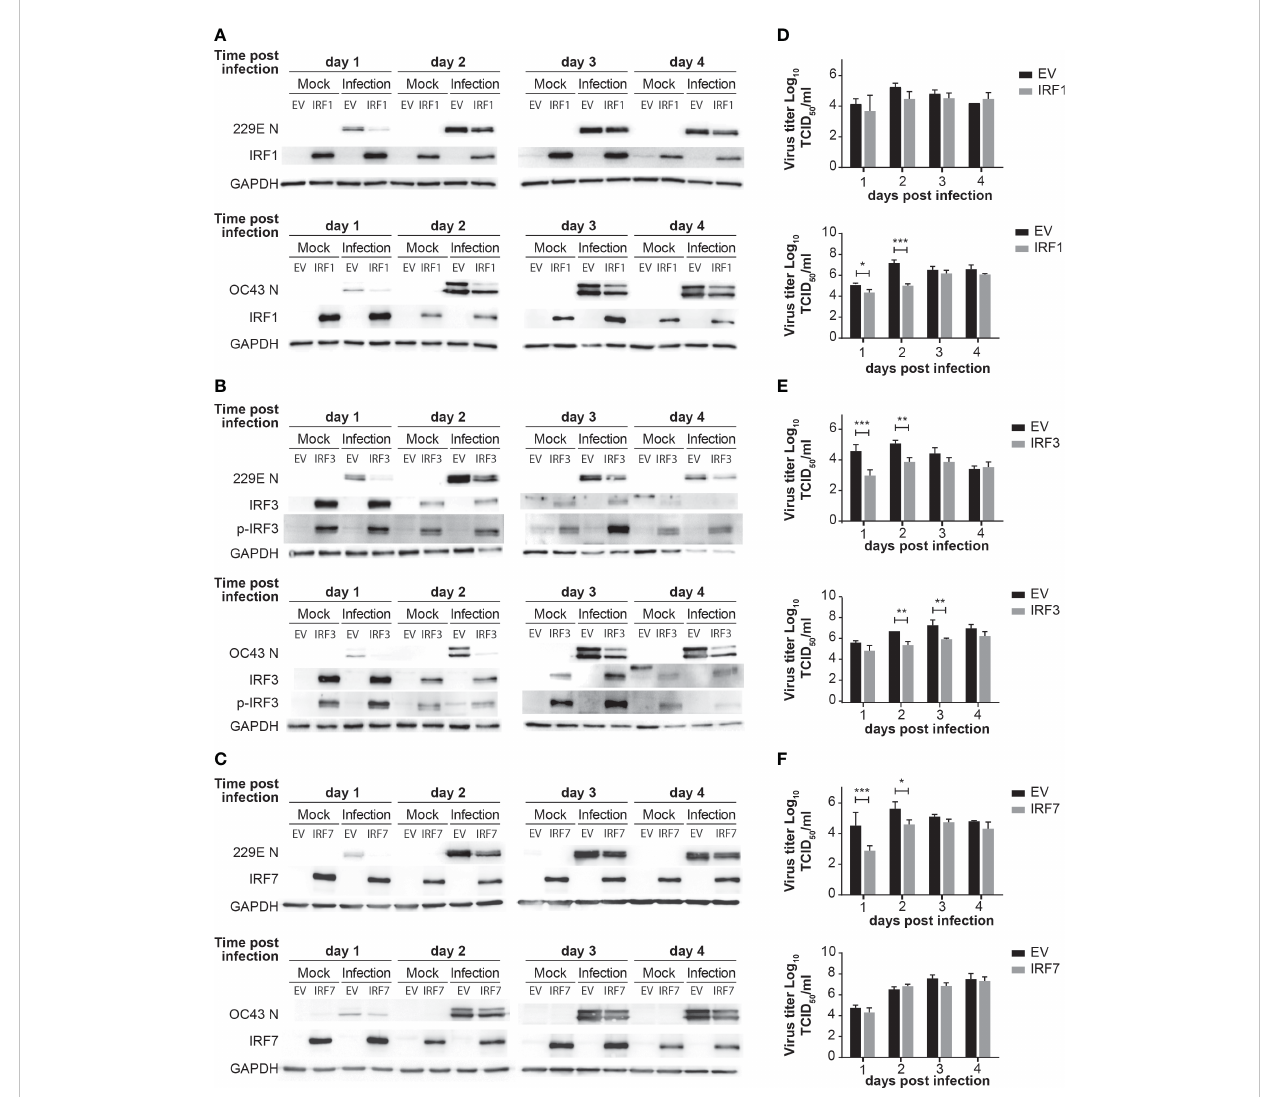
FIGURE 5 Overexpression of IRFs inhibits human coronavirus infection. H1299 cells were transfected with control pcDNA3 empty plasmid (EV) or the plasmid containing IRF1 (A) , IRF3 (B) or IRF7 (C) and then infected with or without 229E or OC43 at MOI of 0.01. Virus infection was determined by western blot analysis using antibodies against 229E N protein, OC43 N protein, IRF1, IRF3, IRF7, phosphorylated IRF3 (p-IRF3) and GAPDH. Amounts of progeny viruses were measured in the supernatant of cells transfected with the plasmid containing IRF1 (D) , IRF3 (E) or IRF7 (F) by TCID 50 assay which were compared to those transfected with empty plasmid (n=6). *p<0.05, **p<0.01, ***p<0.001, Two-way